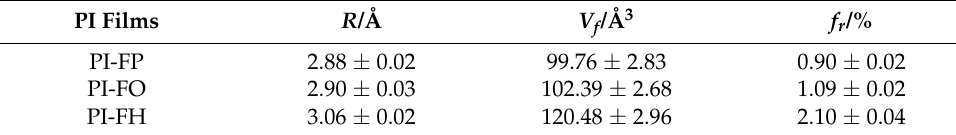
Table 2. The free volume hole parameters of PI